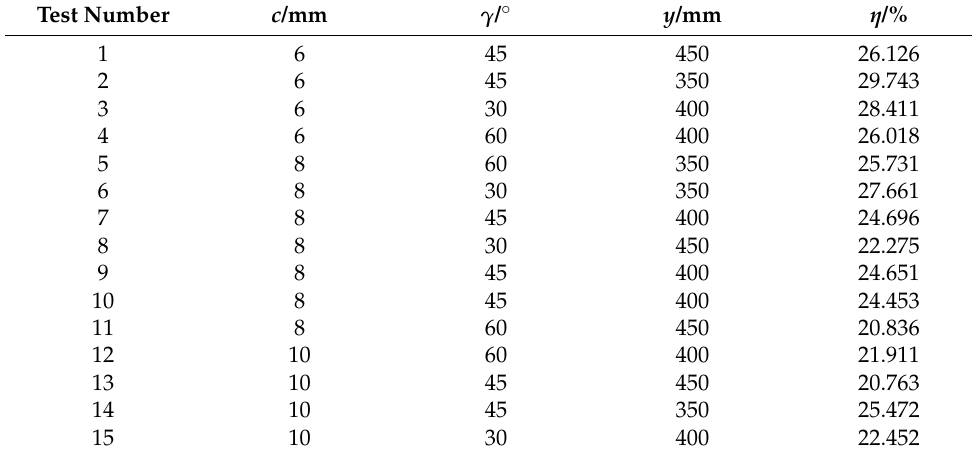
Table 9. Analysis of variance for fluid–soil coupling test.